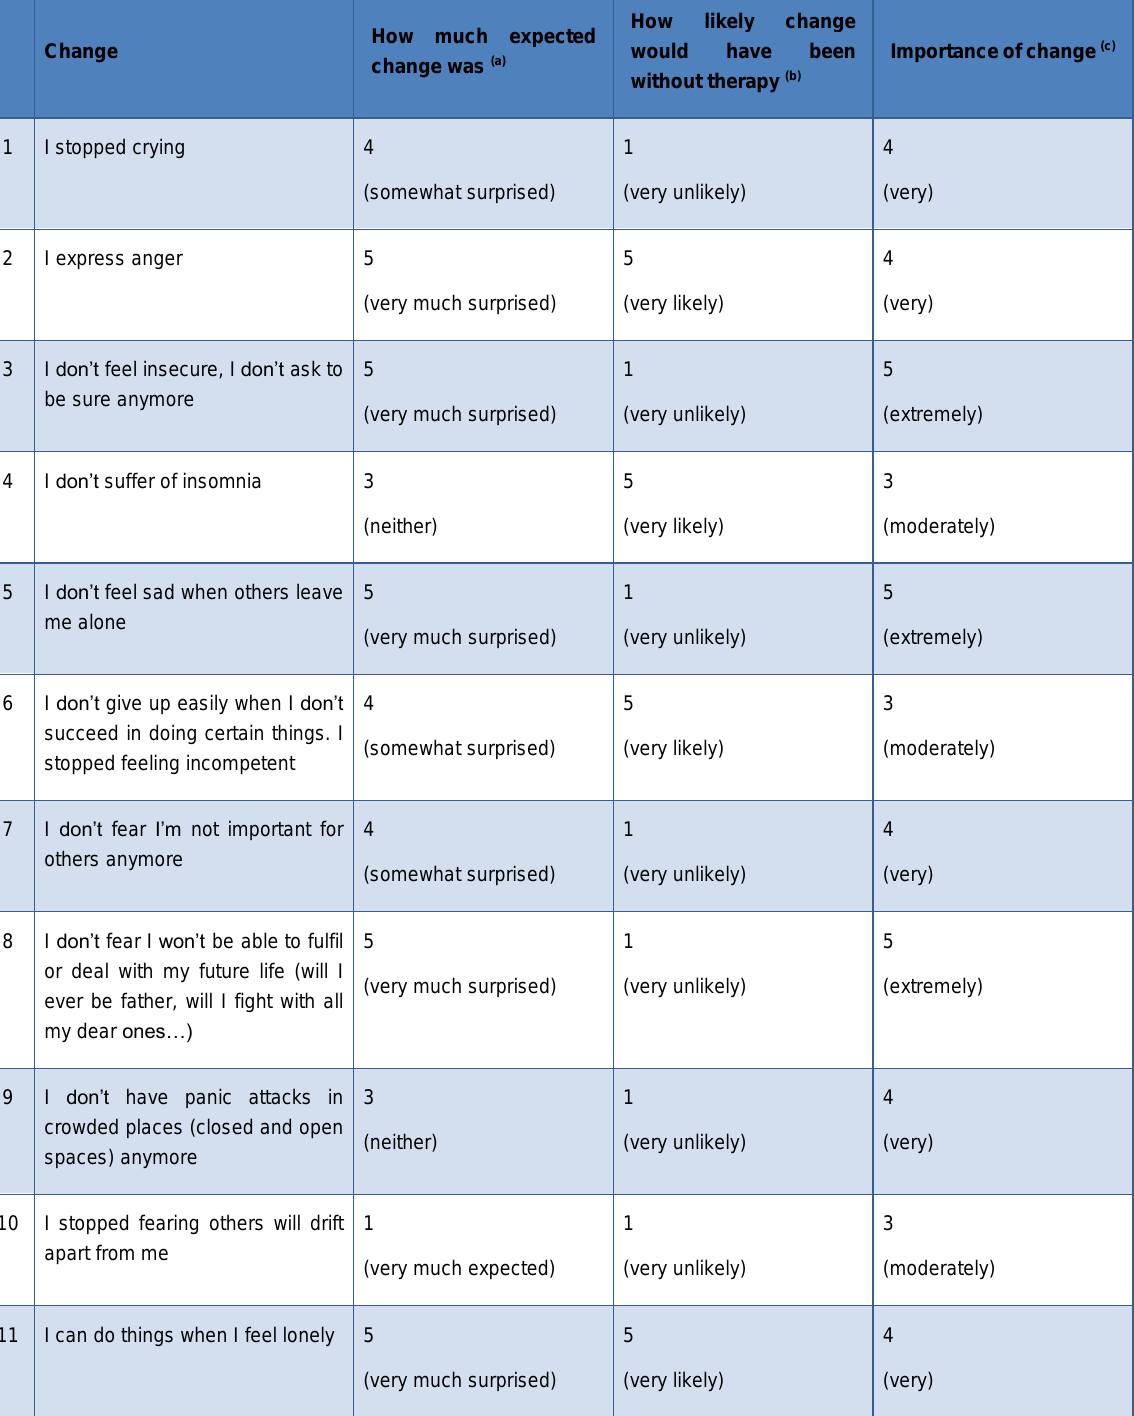
Table 4: Giorgio’s Changes identified in the Change